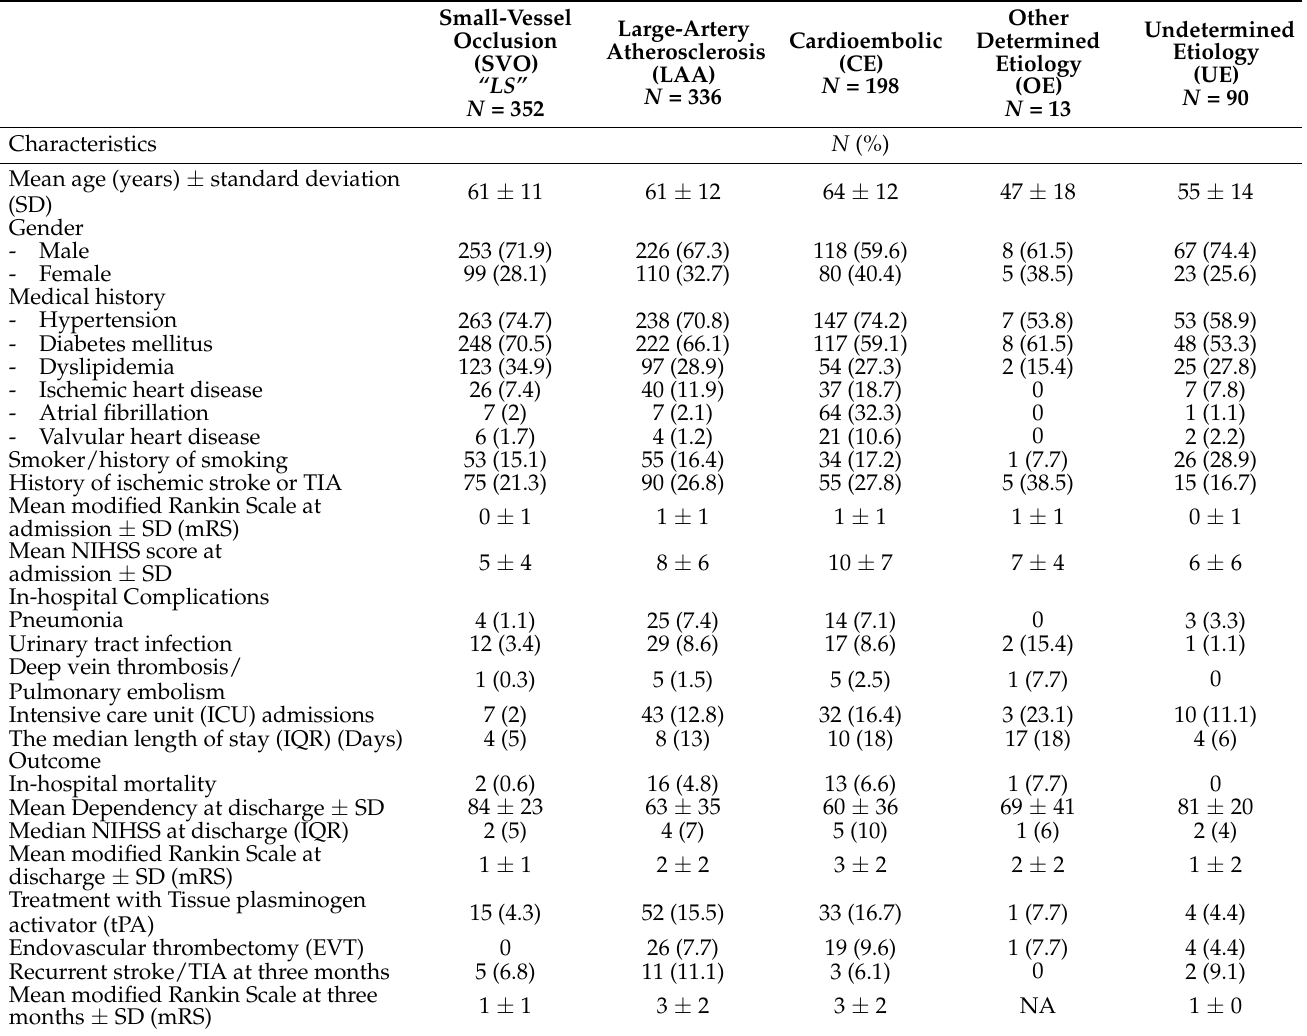
Table 1. Baseline characteristics of the patients ( N = 989) with ischemic stroke based on TOAST classification.